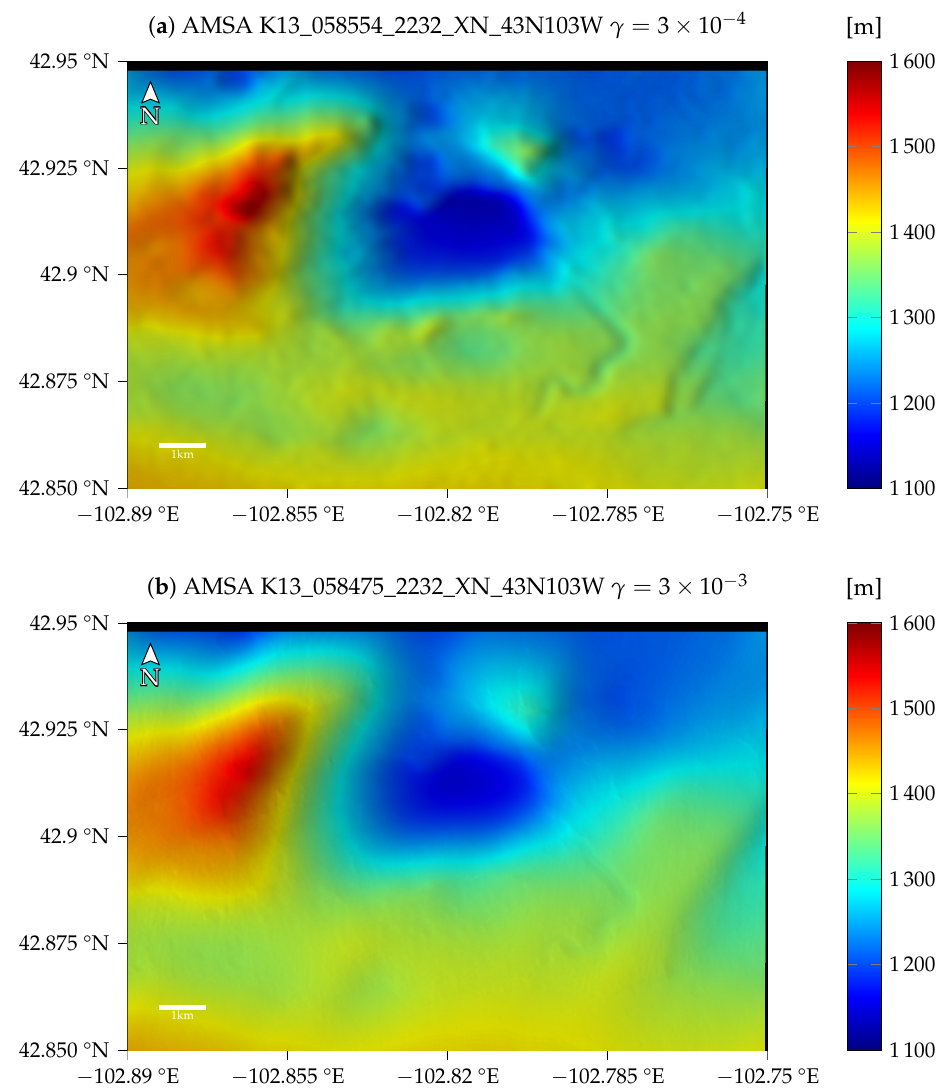
Figure A6. Results for images K13_058554_2232_XN_43N103W and K13_058475_2232_XN_43N103W for the simple AMSA model without atmospheric